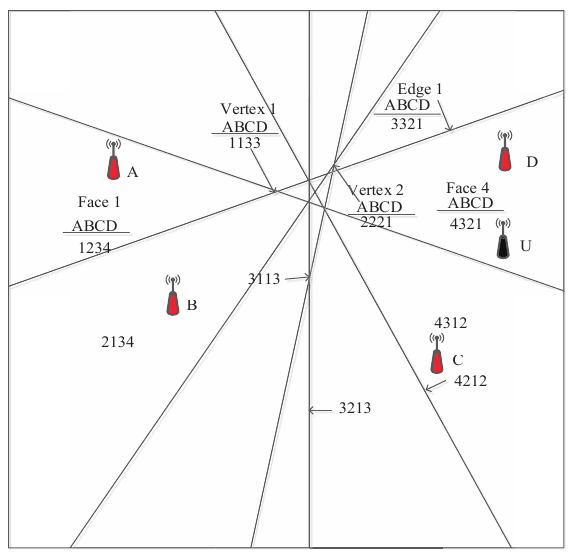
Figure 1. Schematic diagram of sequence-based localization